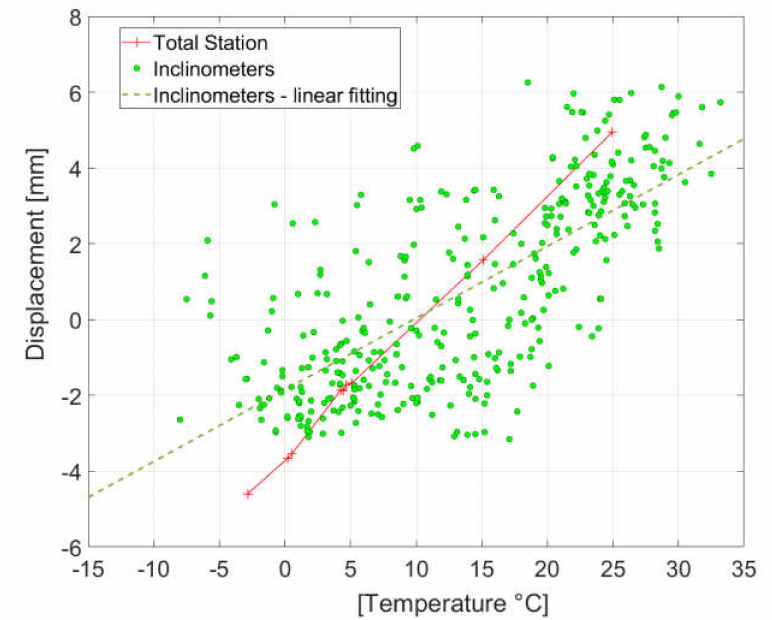
Figure 10. An example of an analysis of a one-day static displacement at 1 temperature measurements versus time; ( b ) indirect measurements of displacement with the use of inclinometer (green points) and total station measurements of displacement (red line with sharps) versus time.